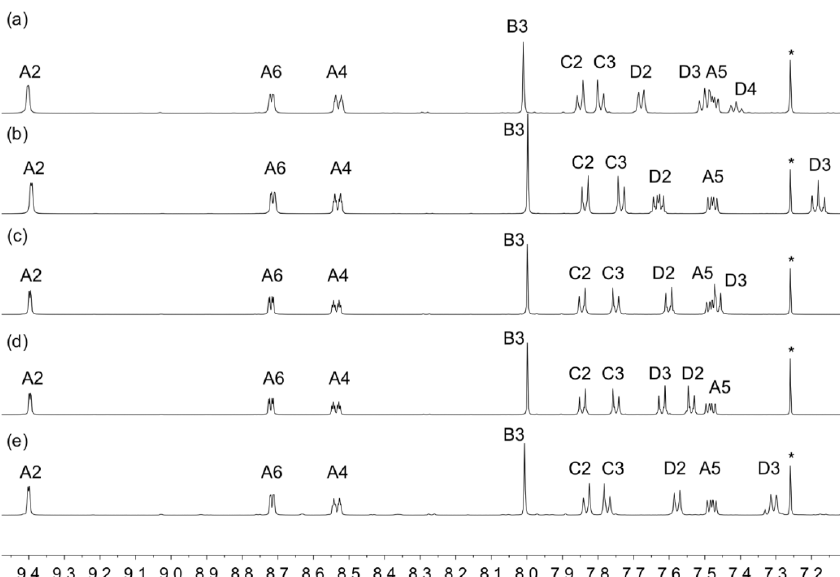
Figure 1. 1 H NMR spectra (aromatic region) for compounds ( a ) 1 , ( b ) 2 , ( c ) 3 , ( d ) 4 and ( e ) 5 (500 MHz, CDCl 3 , 298 K). * = residual CHCl 3 .